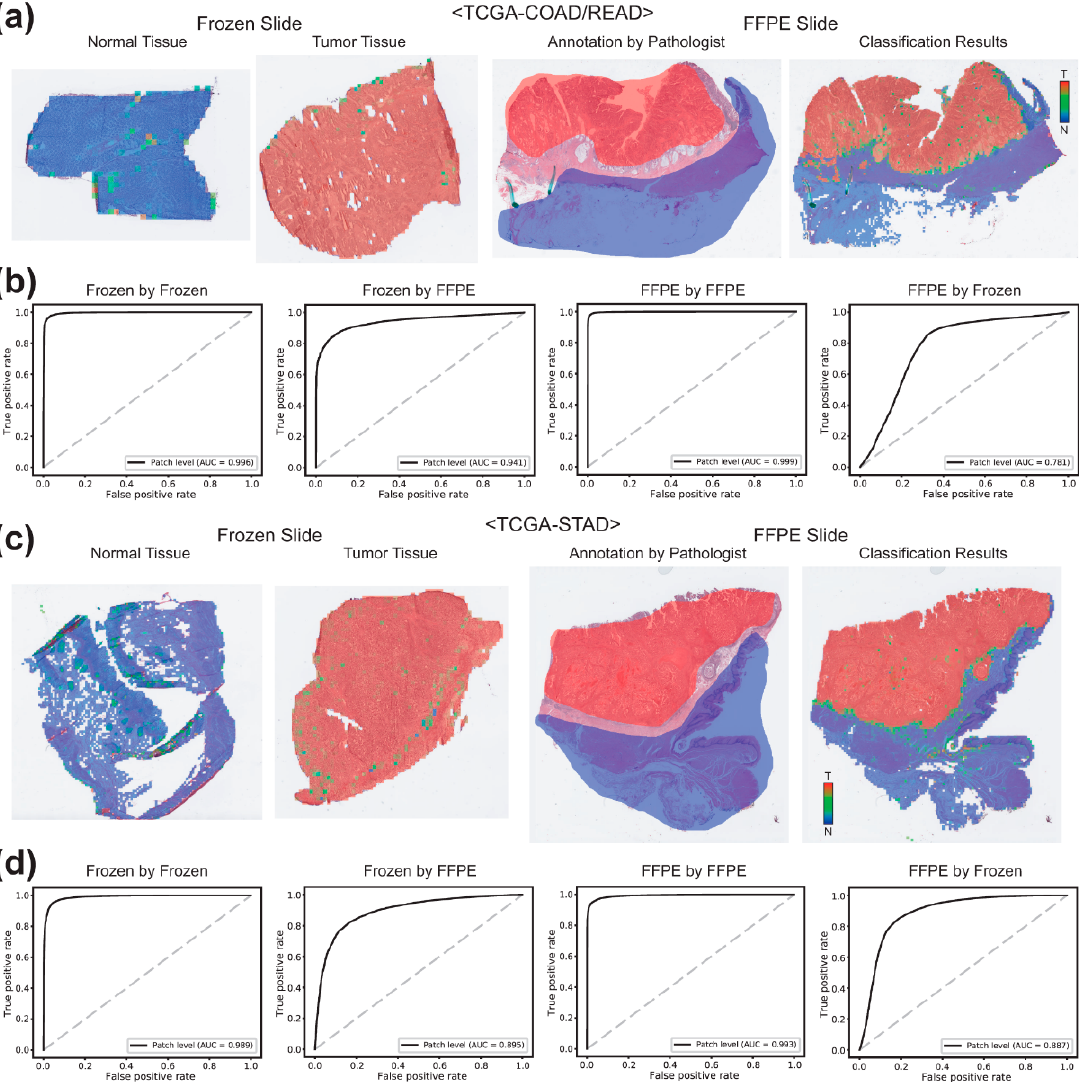
Figure 3. Classification results for the TCGA-COAD/READ and TCGA-STAD datasets. ( a ) Representative classification results. Heatmaps were drawn for the representative whole slide images (WSIs) of the normal and tumor frozen WSIs of the TCGA-COAD/READ dataset (left two images). For a representative formalin-fixed paraffin-embedded (FFPE) WSI, both pathologists’ annotation and the heatmap result were presented for the comparison. ( b ) Receiver operating characteristic (ROC) curves for the classification results. Left two graphs: the ROC curves for the frozen tissues classified by the classifiers trained on frozen and FFPE tissues. Right two graphs: the ROC curves for the FFPE tissues classified by the classifiers trained on FFPE and frozen tissues. ( c , d ) are the same as ( a , b ), but the results were for the TCGA-STAD